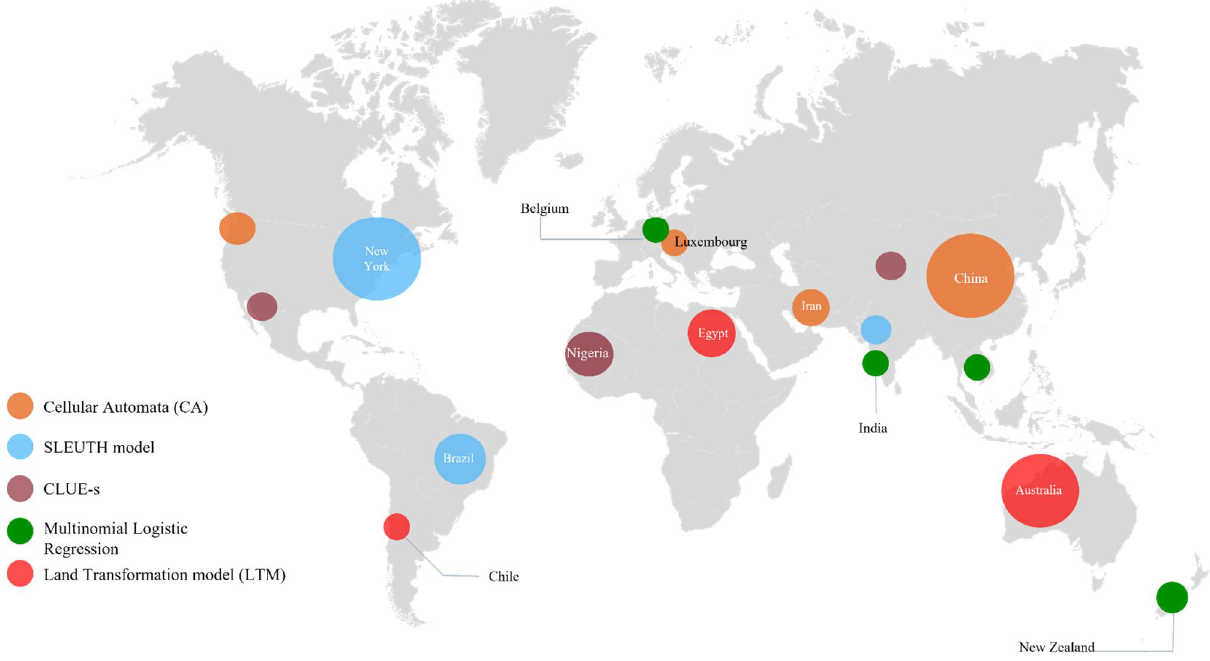
Figure 1 . Global distribution of different urban growth model . Figure 1. Global distribution of different urban growth